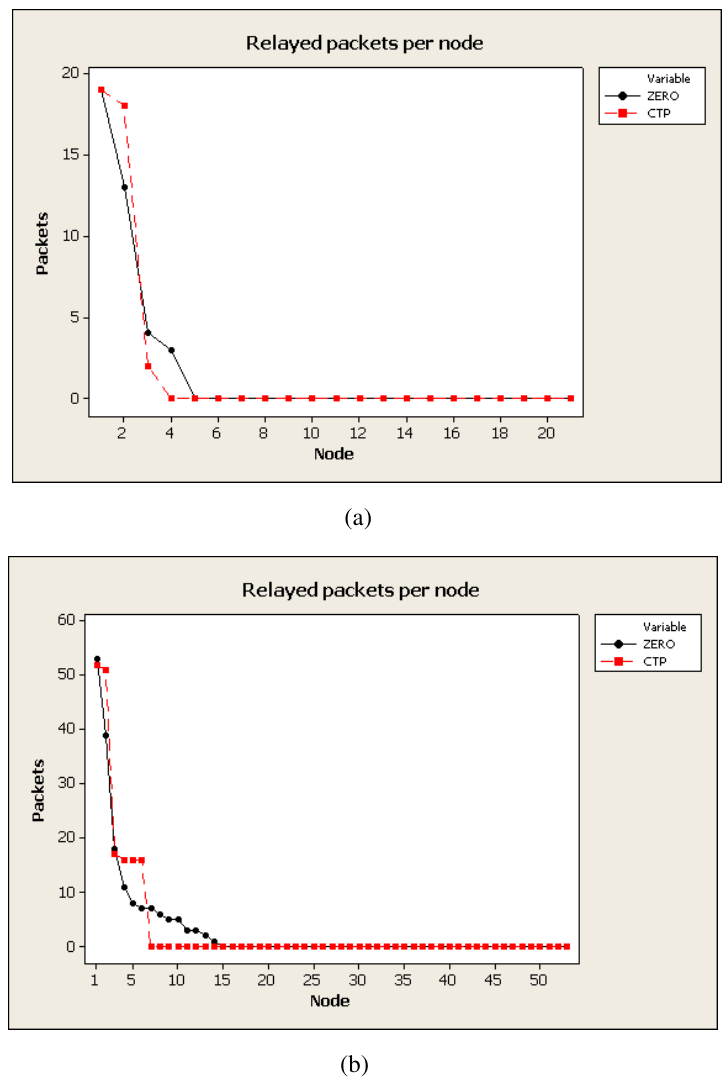
Figure 9. Number of packets relayed per node. (a) Relayed packets per node in the 21 nodes deployment, (b) Relayed packets per node in the 54 nodes